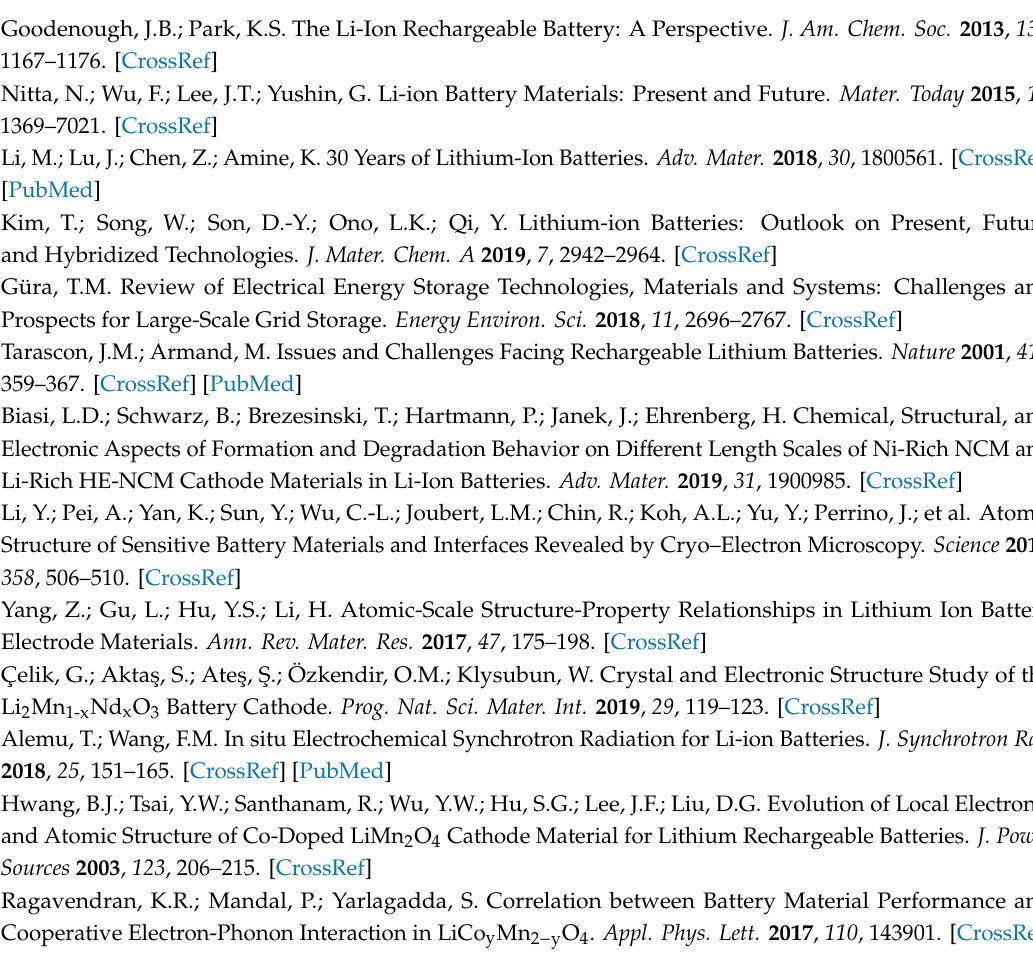
Figure S1: Mn L -edge NEXAFS spectra of NCM811 with reference oxide; Figure S2: Co L -edge NEXAFS spectra of NCM811 with reference oxide; Figure S3: Ni L -edge NEXAFS spectra of NCM811 with NiO; Figure S4: Positions of spectral features A 1 and B 1 of Mn L -edge spectra for various states; Figure S5: Positions of spectral features A 2 and B 2 of Co L -edge spectra for various